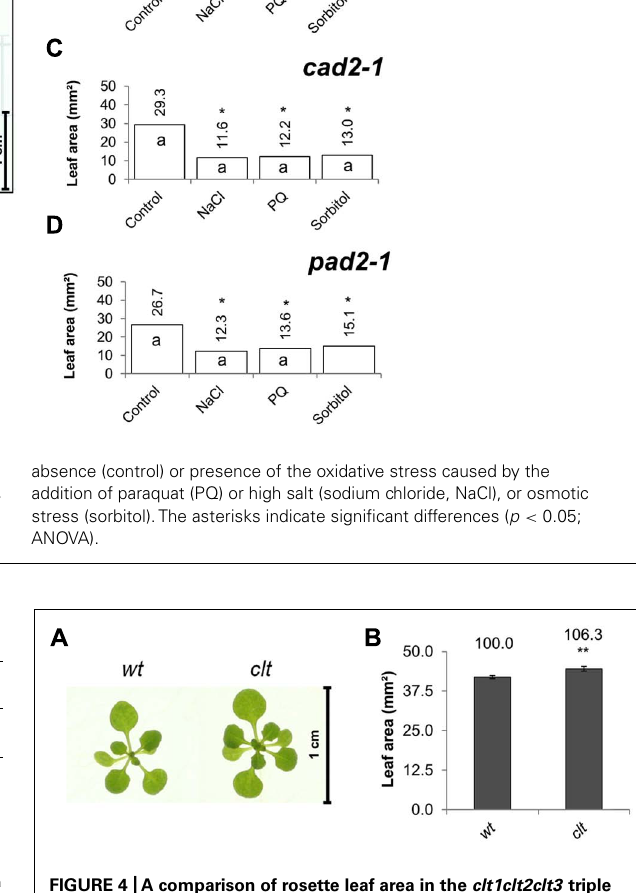
FIGURE 4 |A comparison of rosette leaf area in the clt1clt2clt3 triple mutants ( clt ) relative to wild type, Col-0 (wt). Phenotypes (A) and leaf area of seedlings at 14 days ( B ; ** p <